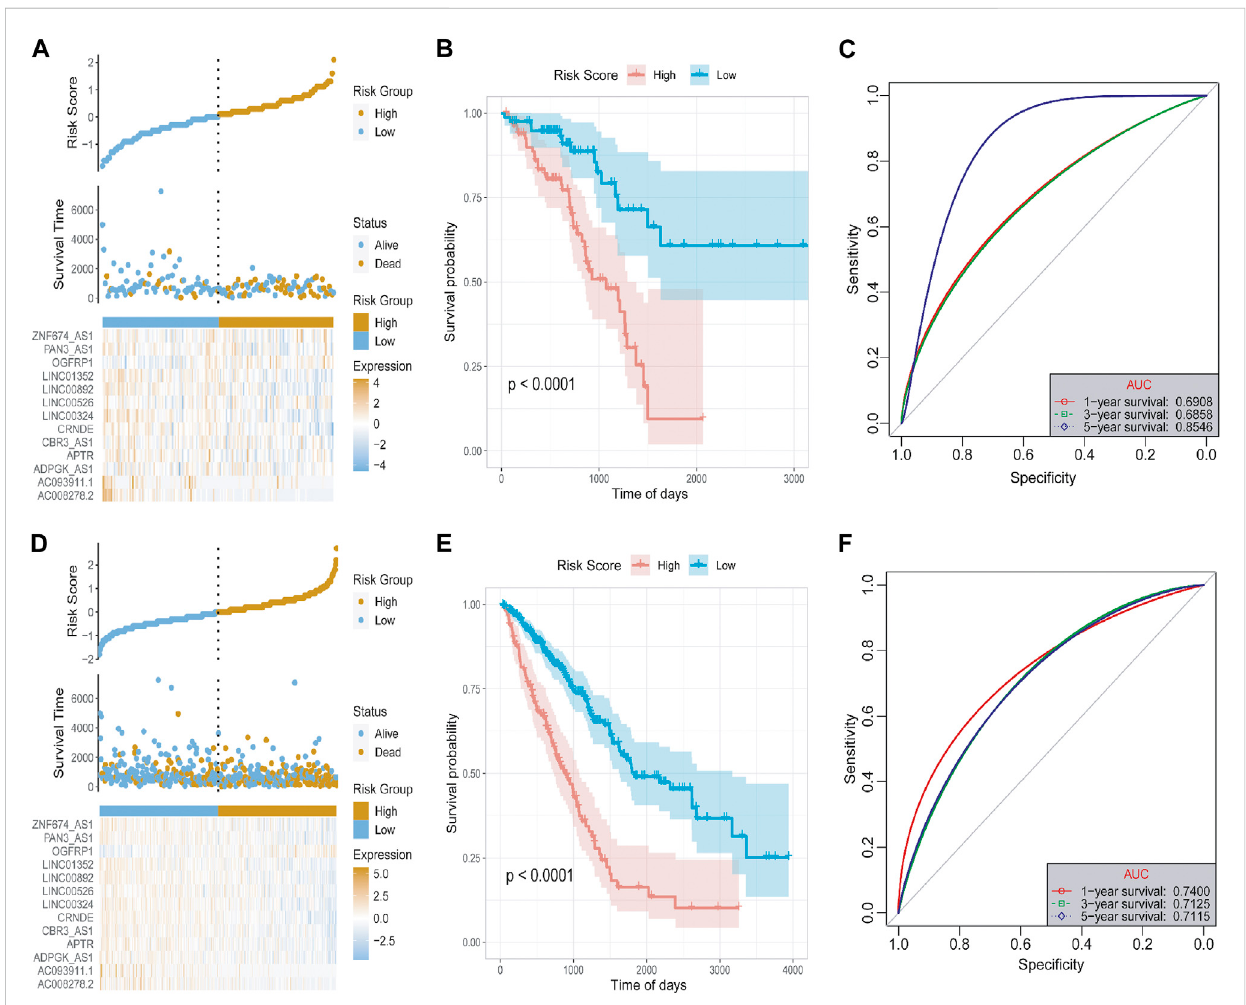
FIGURE 6 Test set and overall set to verify the risk model. (A) The distribution diagram of the risk score of the test set. (B) The survival curve of the test set. (C) The 1-, 3-, and 5- year ’ s ROC curves of the test set. (D) Distribution chart of the risk score of the overall set. (E) Survival curve of the overall set. (F) The 1-, 3-, and 5- year ’ s ROC curve of the overall